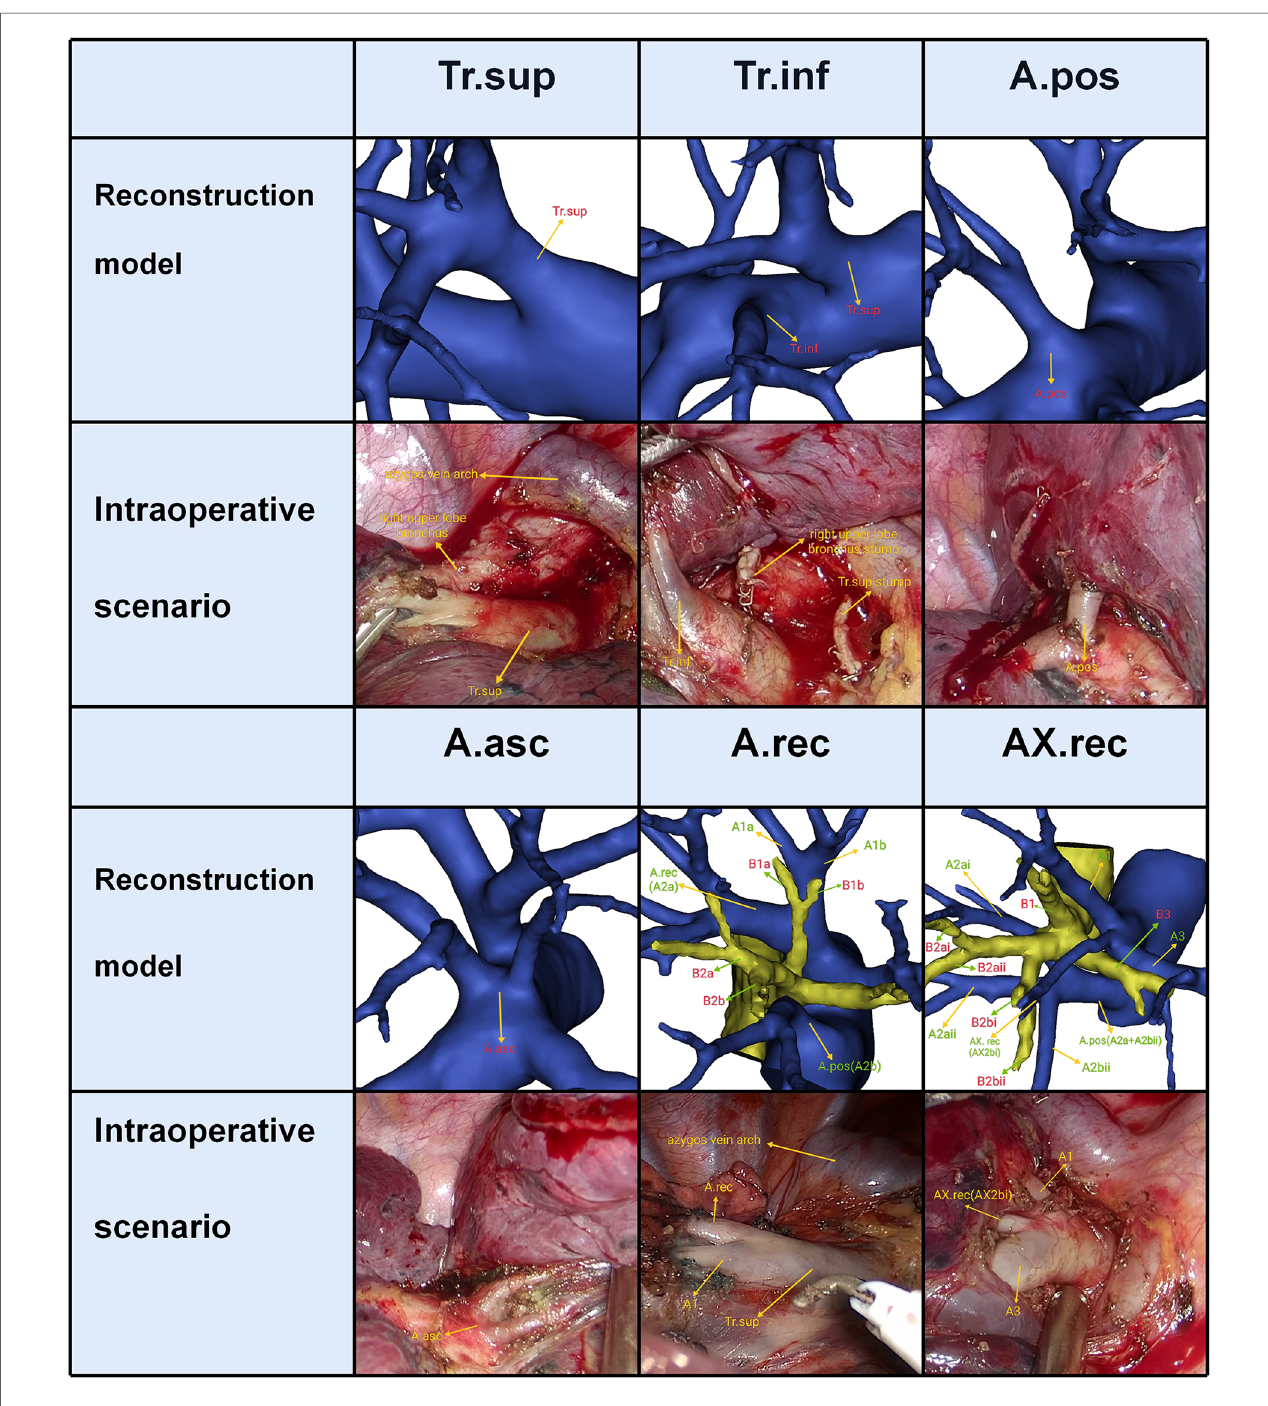
FIGURE 3 The 3D reconstruction model of the RUL